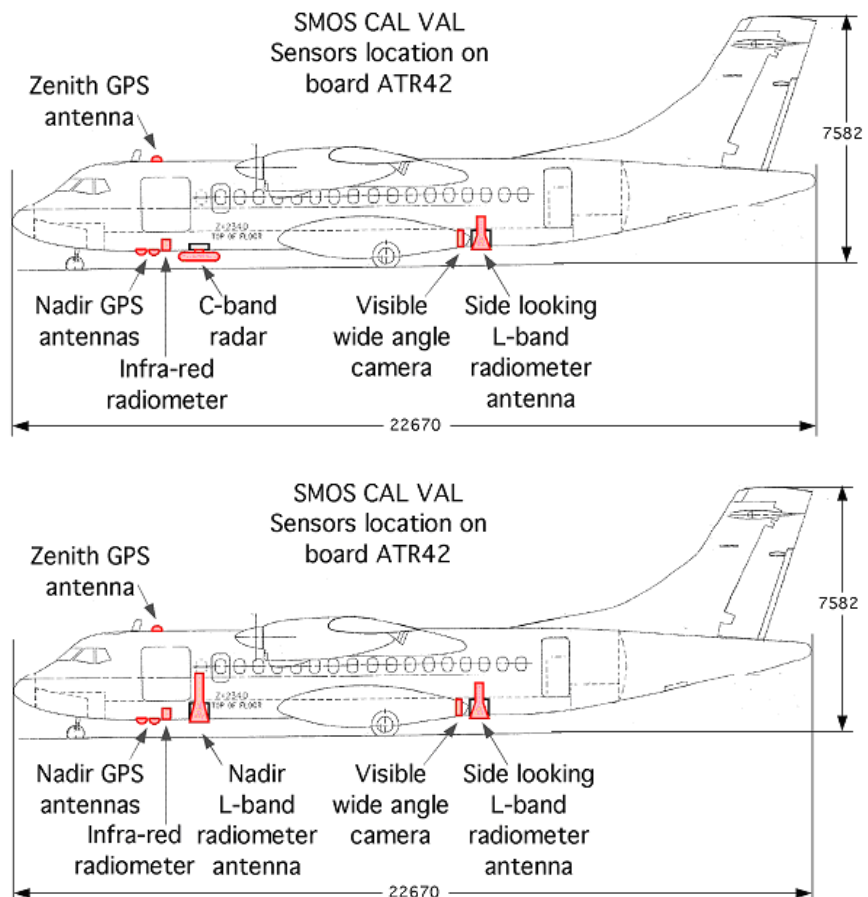
Figure 6. a. (top) CAROLS instrument with one slant antenna and the STORM instrument, b. (bottom) CAROLS instrument with two antennas (one slant and one